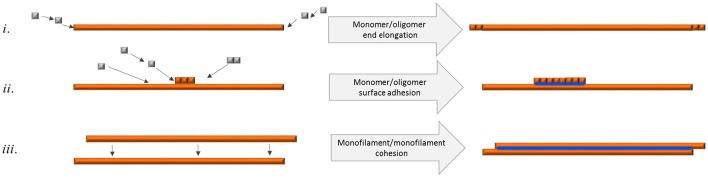
Schematic figure of different means of fibril elongation and association and how it affects q-FTAA binding propensity. Orange depicts h-FTAA positive fibrils, blue depicts q-FTAA binding sites (i) End addition of monomers or oligomers does not generate the q-FTAA binding site. (ii) Monomer or oligomer adhesion to the long end fibril surface generates additional binding site that enables q-FTAA binding. (iii) Cohesion of two monofilaments generates the q-FTAA binding site.